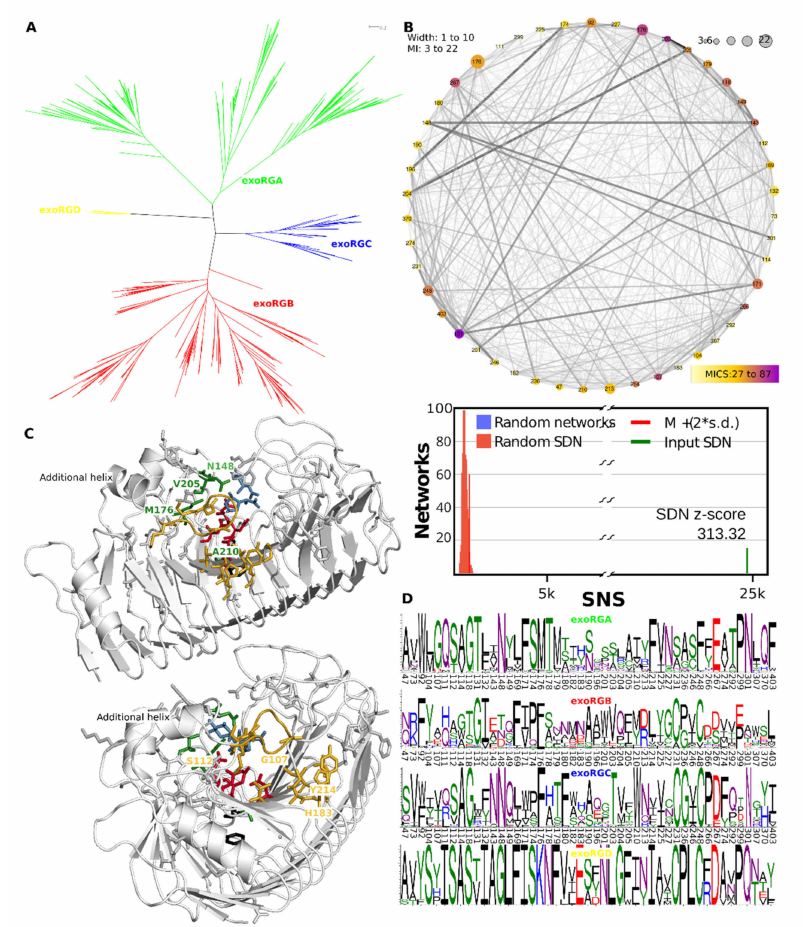
Figure 9. Functional diversification of the ascomycete exoRG subfamilies involves T3 loops that cover subsite − 1. ( A ) Fungal exoPG tree clustered with HMMERCTTER; ( B ) SDN of ex- oRGA/exoRGB/exoRGC comparison. The graph shows the Specific Network Score (SNS) compared with 1000 random SDNs; ( C ) SDP mapping in two different angles. The structure model of exoRG A0A194WYS5_9HELO (grey cartoon) is aligned to 1KCD to show the approximate location of the substrate (galacturonates in blue stick). Catalytic residues are in red stick. Highlighted in green are the residues that appear close to the site. Highlighted in gold are the residues that appear close to subsite − 1 where supposedly the rhamnose-moiety binds. In black stick the counterpart of disulphide bridge SS2 that is lacking in exoRGA; ( D ) SDP logos with A0A194WYS5_9HELO